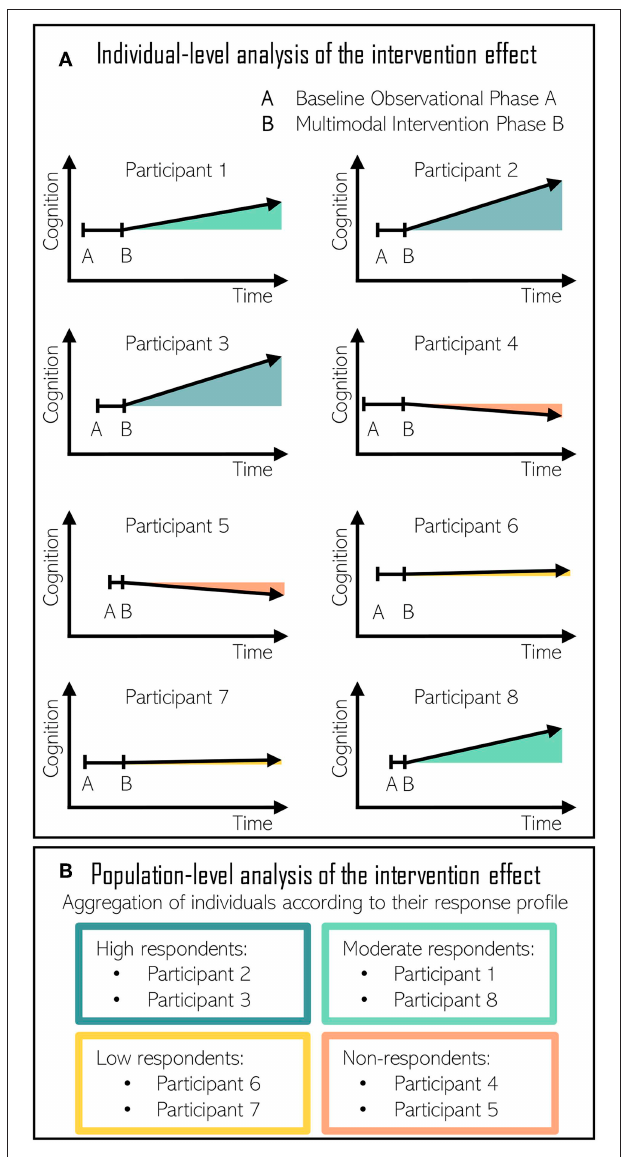
FIGURE 3 | (A) Individual-level analysis of the intervention effect in N-of-1 nutritional studies directed at improving cognitive function. Baseline observational phase A duration is randomized among volunteers. Multimodal intervention phase B triggers a different response to each individual. (B) Population-level analysis of the intervention effect. Individuals are aggregated according to their response. High respondents and moderate respondents improved their cognitive performance following the intervention. Low respondents maintained cognitive performance with the intervention. Finally, cognitive decline progressed in non-respondents despite the